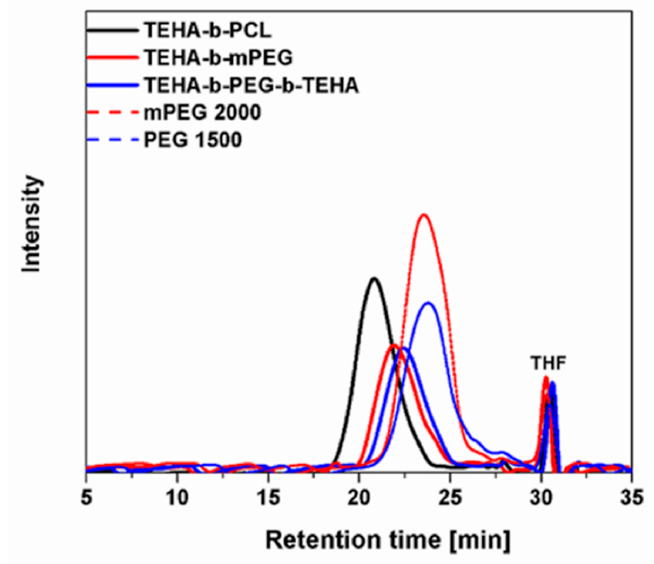
Figure 3. SEC traces of TEHA-b-PCL, TEHA-b-mPEG, and TEHA-b-PEG-b-TEHA block copolymers, compared to the peaks obtained for mPEG 2000 and PEG 1500.